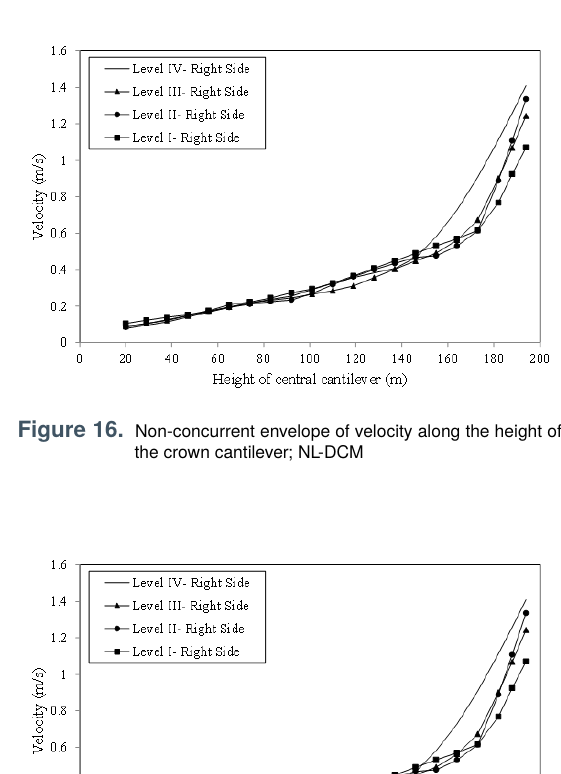
I . It seems that the joint between blocks weakens due to the application of the resultant forces to the node and this leads to movements with high acceleration called projec- tile motion.